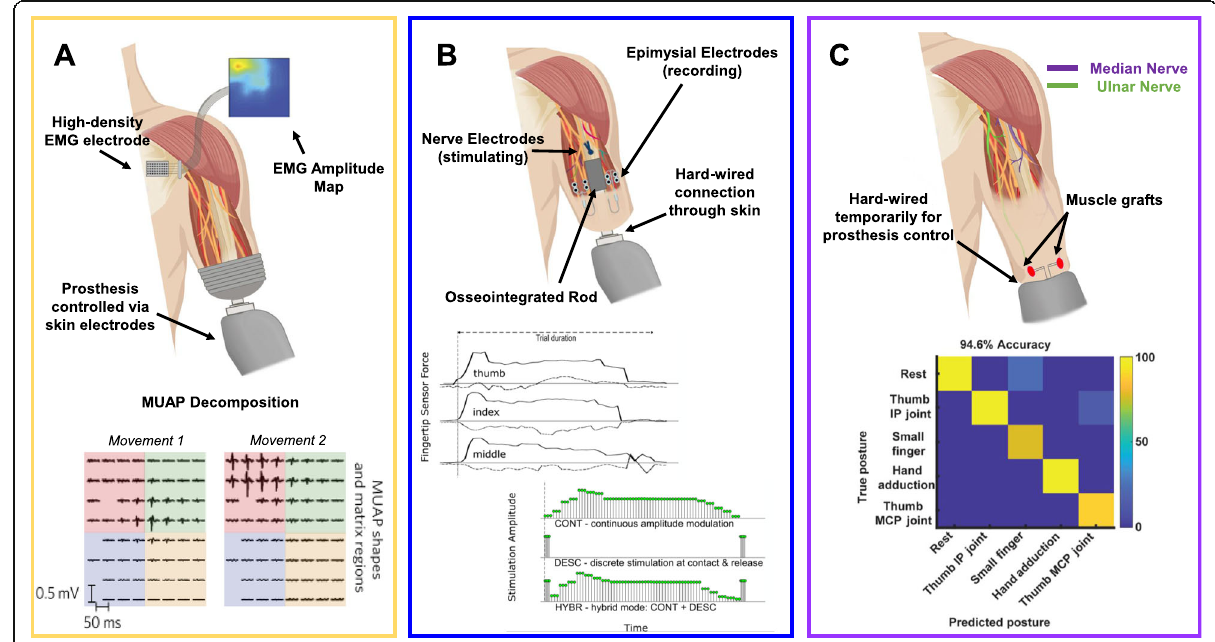
Fig. 4 Reinnervated Muscle Interfaces. a The most common signal used for controlling myoelectric prostheses is sEMG. These voltages are detected from the skin through removable electrode contacts (top). The most accurate signal interpretation is through motor unit decomposition. An sEMG signal is broken down by an algorithm into the individual firing rates of unique motor units (bottom). This algorithm requires high-density surface electrode arrays (Farina et al., 2017). b Implanted electrodes can be used to record eEMG signals for prosthesis control. Currently, the best method for doing this in human subjects is to connect the electrodes with an osseointegrated implant that interfaces with the external prosthesis, a.k.a. the e-OPRA (top). These implants require that there be a permanent opening in the skin. The e-OPRA presents an opportunity for developing stable bi-directional interfaces. eEMG signals can control the robotics, and nerve cuff electrodes implanted in the residual limb can be used to provide stimulation based on signals from artificial touch sensors that are within the prosthesis (bottom) (Mastinu et al., 2020). c RPNI muscle grafts have been shown to be useful for prosthesis control. The only published human trials so far recorded iEMG signals using temporary bipolar electrodes that were implanted percutaneously in the RPNI muscles of 2 upper-limb amputees (top). Simple amplitude-based classification algorithms could be used to reliably operate a prosthetic hand through a series of complex gestures by using the iEMG signals recorded from multiple RPNIs (bottom) (Vu et al.,